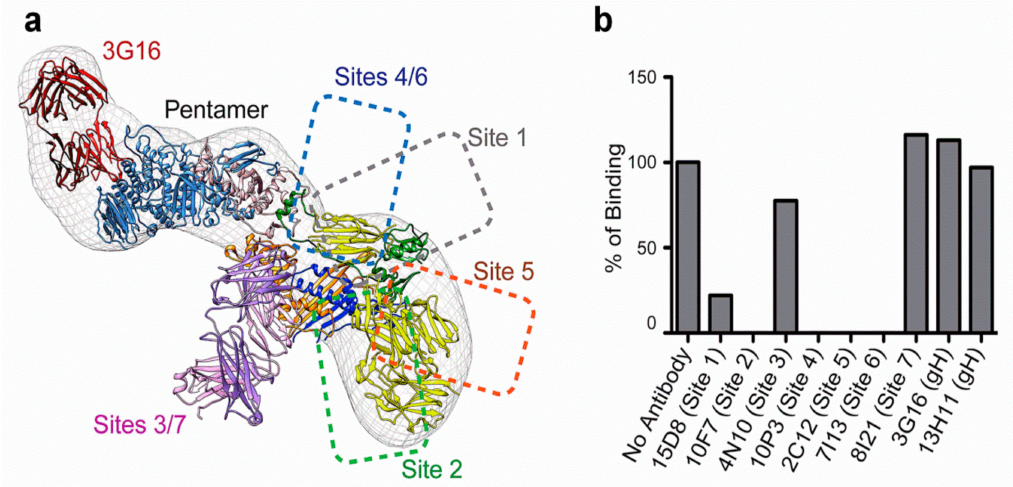
Figure 4. ( a ) Summary of the HCMV pentamer epitope mapping. ( b ) In vitro binding of neutralizing mAbs to pentamer epitopes, which, with the exception of mAbs targeting site 3 / 7, sterically block Nrp2 pentamer binding (from